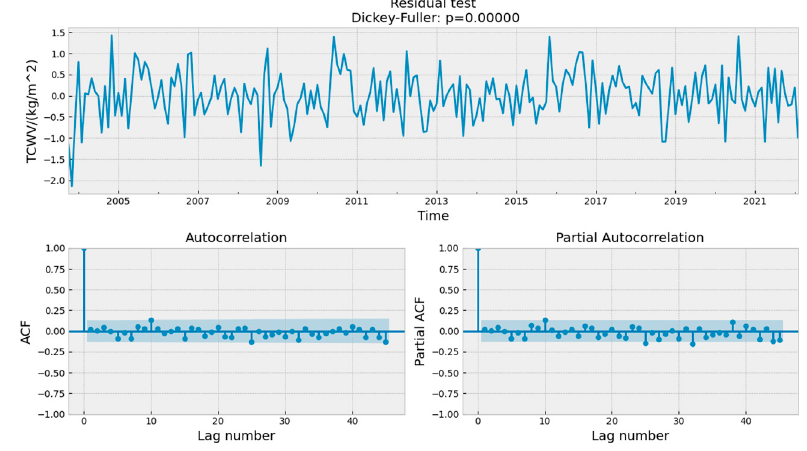
Figure 10. Residual test.